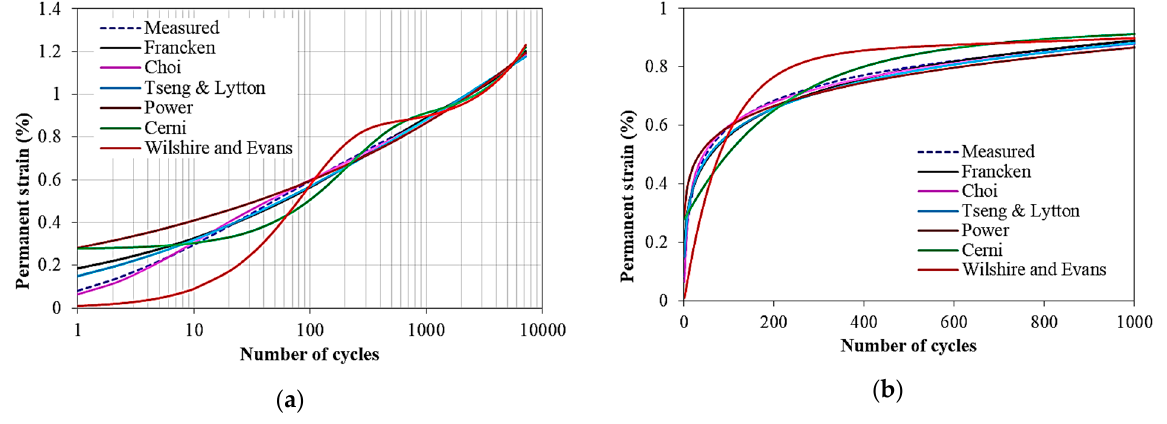
Figure 3. Example—permanent deformation prediction of some models using test data: ( a ) logarith- mic scale and ( b ) normal scale.